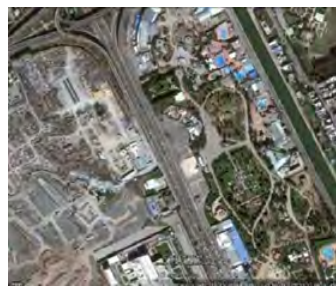
Figure 7. A well-constructed urban context around the Suez Canal Road (Google Earth, 2017.